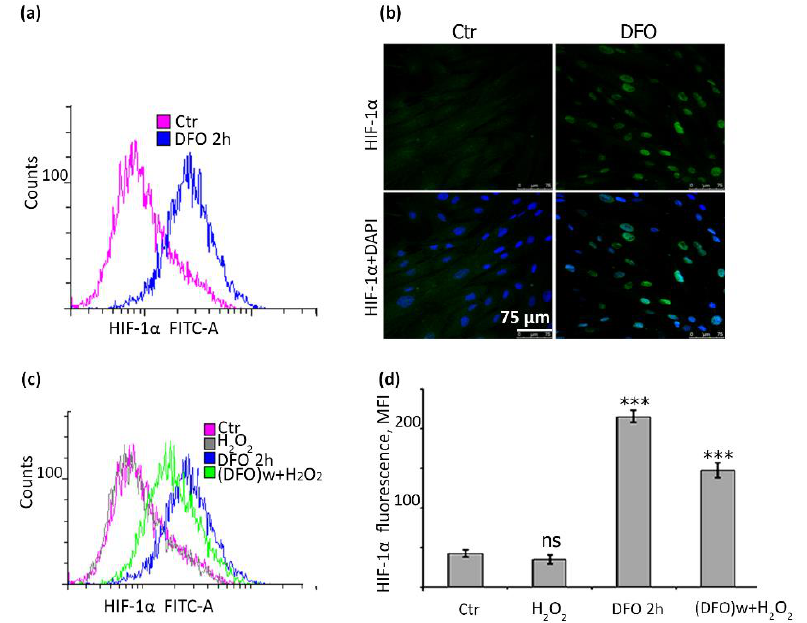
Figure 7. DFO pretreatment induced HIF-1 α accumulation both in control and H 2 O 2 -treated hMESCs. Cells were cultured in the presence of 1 mM DFO for 2 h, stained with anti-HIF-1 α antibodies and assayed by FACS ( a ) and by immunofluorescence ( b ); ( c ) FACS analysis of cells stained with anti-HIF-1 α antibodies: untreated (ctr), H 2 O 2 -treated for 1 h (H 2 O 2 ), DFO-treated for 2 h (DFO 2 h), DFO-pretreated for 2 h, washed and exposed to 200 µ M H 2 O 2 for 1 h ((DFO)w+H 2 O 2 ); the same data is shown graphically ( d ). Data are shown as Mean ± SD, n = 3; *** p < 0.005; immunofluorescence 100 × magnification; scale bar = 75 µm.